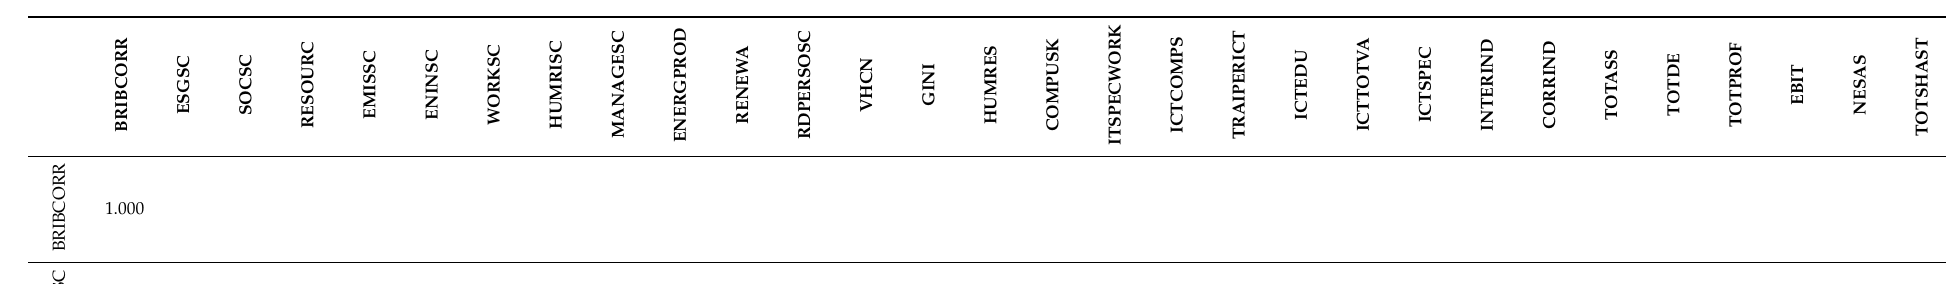
Table 5. Correlation